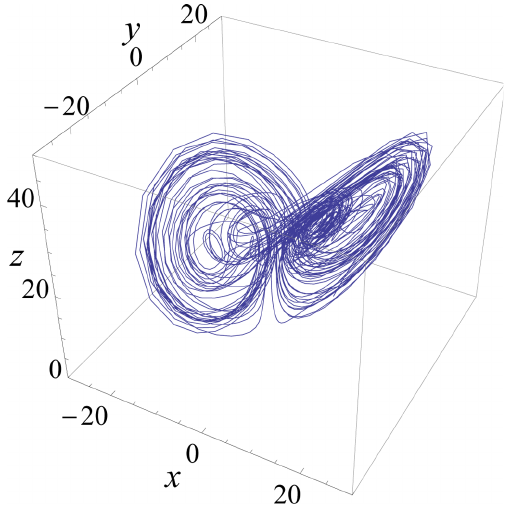
Fig. 1. Projection of the observations in the model space. The trajec- tory resembles those obtained from the ordinary Lorenz 63